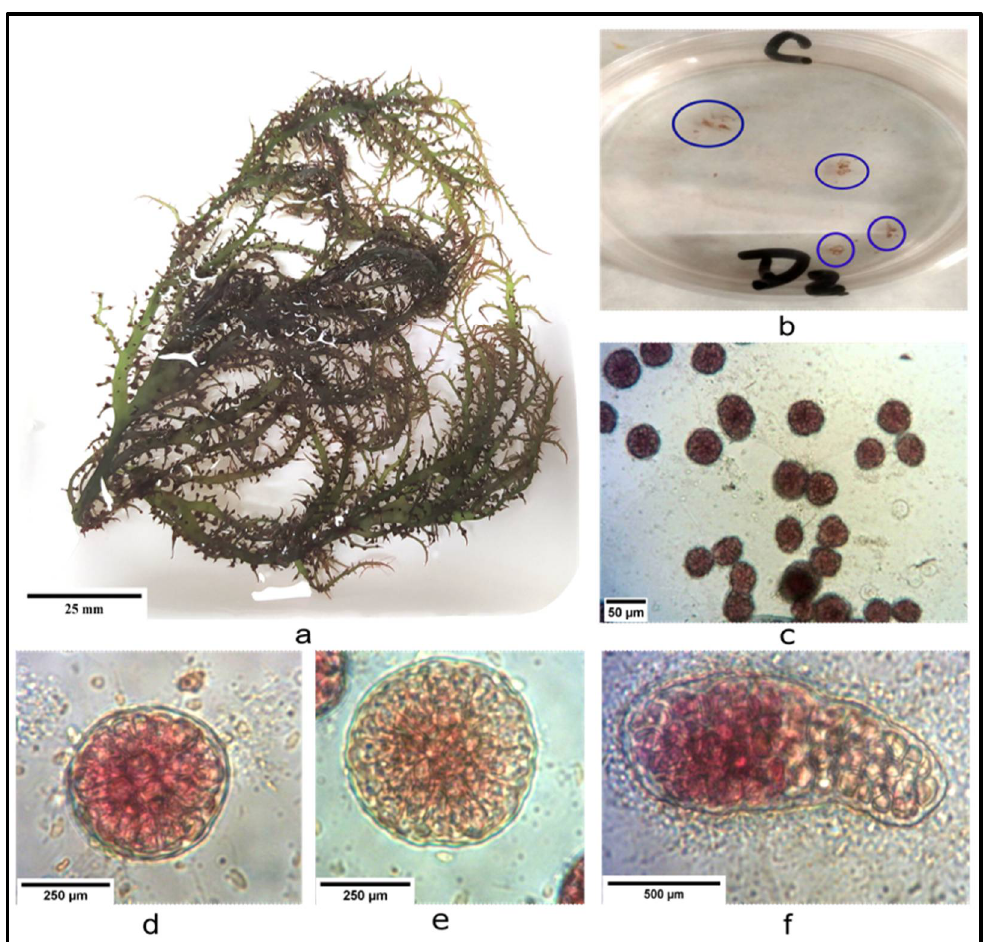
Figure 6. Chondracanthus teedei. ( a ) Adult specimen (female gametophyte). ( b ) Sporulation on the second day of cultivation in Miquel A + B medium; the red spots at the bottom of the Petri dish are enclosed in blue circles. ( c ) Spores in ES medium. ( d ) Beginning of basal disc development after ca. 7 days of cultivation. ( e ) Basal disc developed (15 days of cultivation). ( f ) Emerging frond developed after 35 days of cultivation.